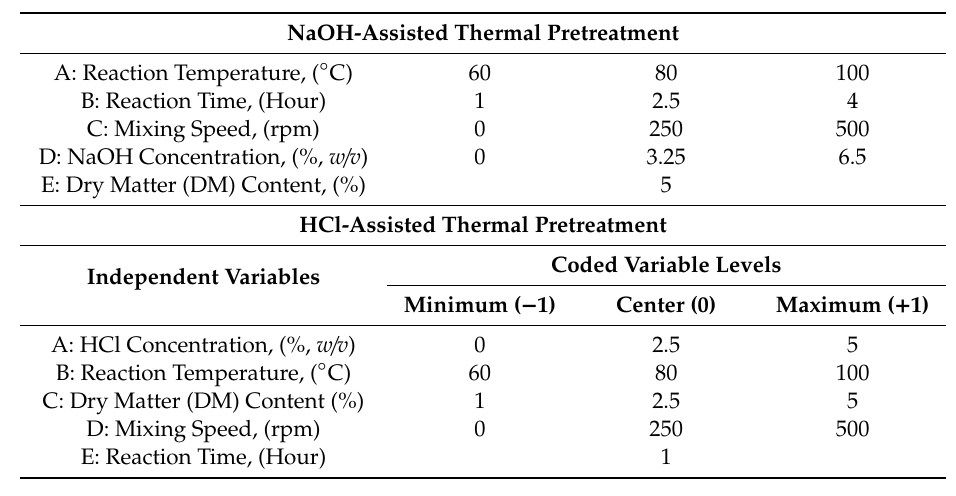
Selected independent variables and their ranges for NaOH- and HCl-assisted thermal